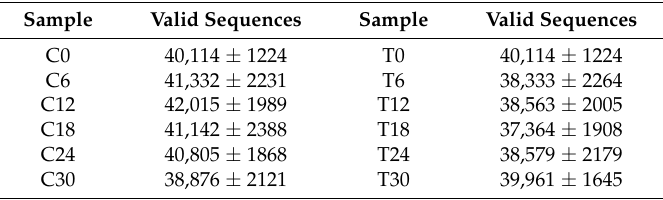
Table 1. The number of reads per each sample